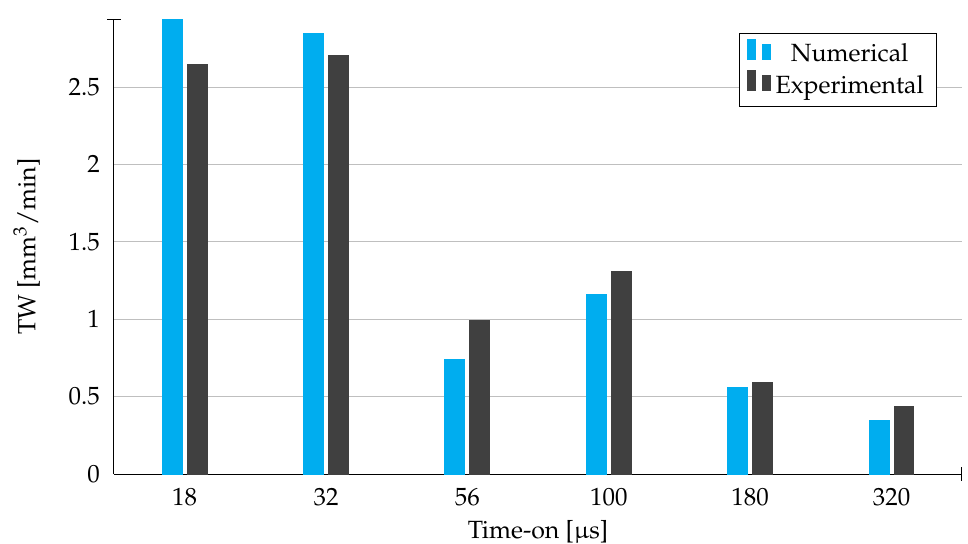
Figure 10. Tool Wear Rate results obtained from experimental work and numerical simulation in Abaqus.